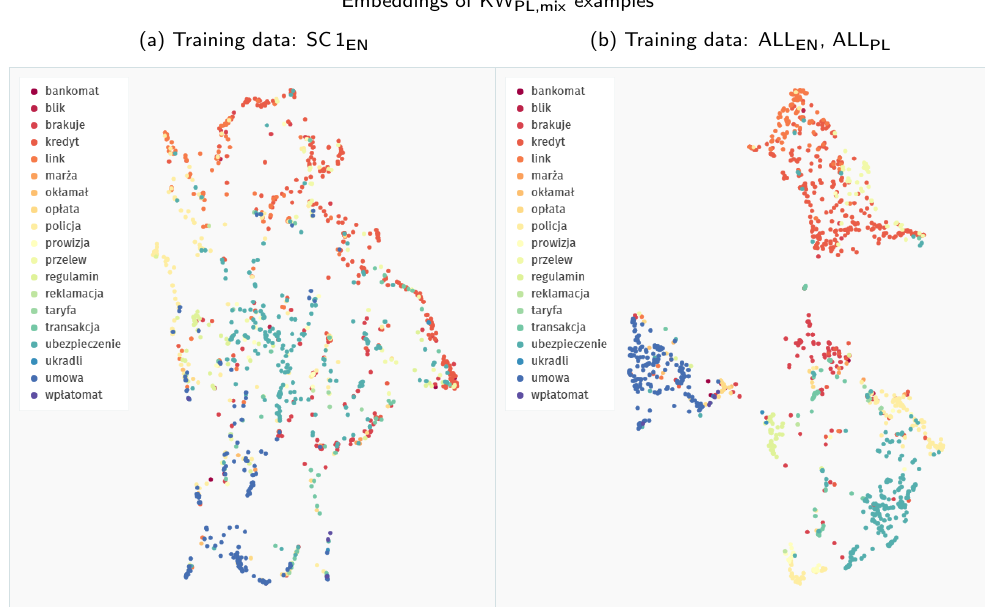
Figure 6. Comparison of the UMAP visualisations of Polish keywords processed through the Siamese embedder: ( a ) embeddings generated with a model trained only on the Speech Commands data; ( b ) embeddings generated with a model trained on all the available data (both English and Polish); Polish keywords are extracted directly from YouTube videos. Synthetic mixtures of these keywords are denoted as KW PL,mix throughout the results